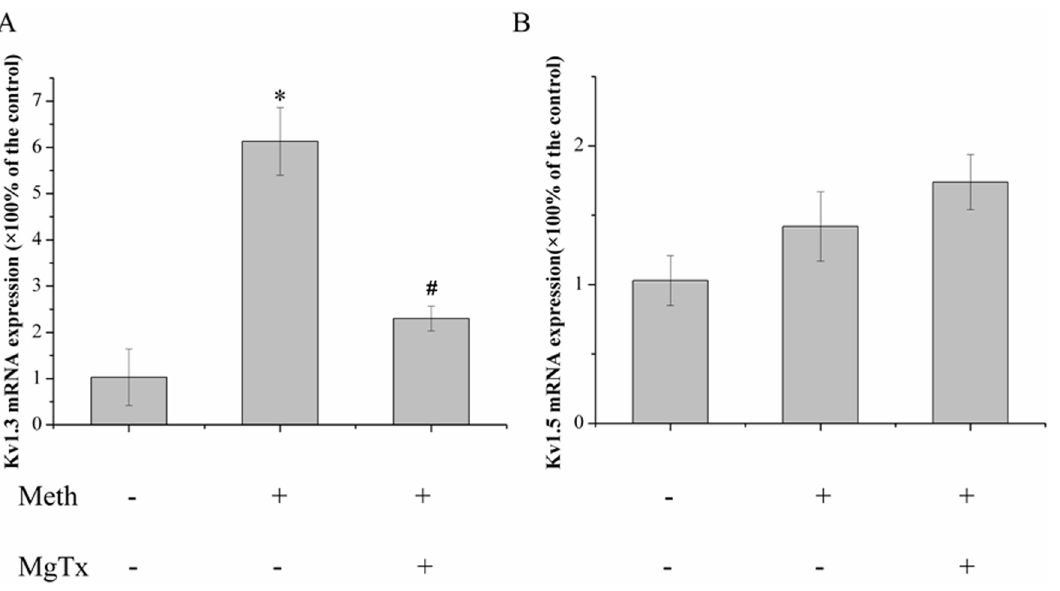
Figure 4. Meth increased Kv1.3 mRNA expression rather than Kv1.5. Microglial cells were incubated with Meth (300 m M) for 24 h, and the mRNA level was detected by realtime-PCR. (A) Meth significantly increased the Kv1.3 mRNA expression, while MgTx ameliorated the expression of Kv1.3 mediated by Meth. (B) Meth showed no obvious impact on Kv1.5 mRNA expression. Each data point represents mean 6 SD of mRNA levels from at least three separate experiments in which treatments were performed in triplicates.* and # indicate significant differences compared with the control and condition stimulated by Meth respectively (p , 0.05 by ANOVA), each data represents mean 6 SD at least three separate